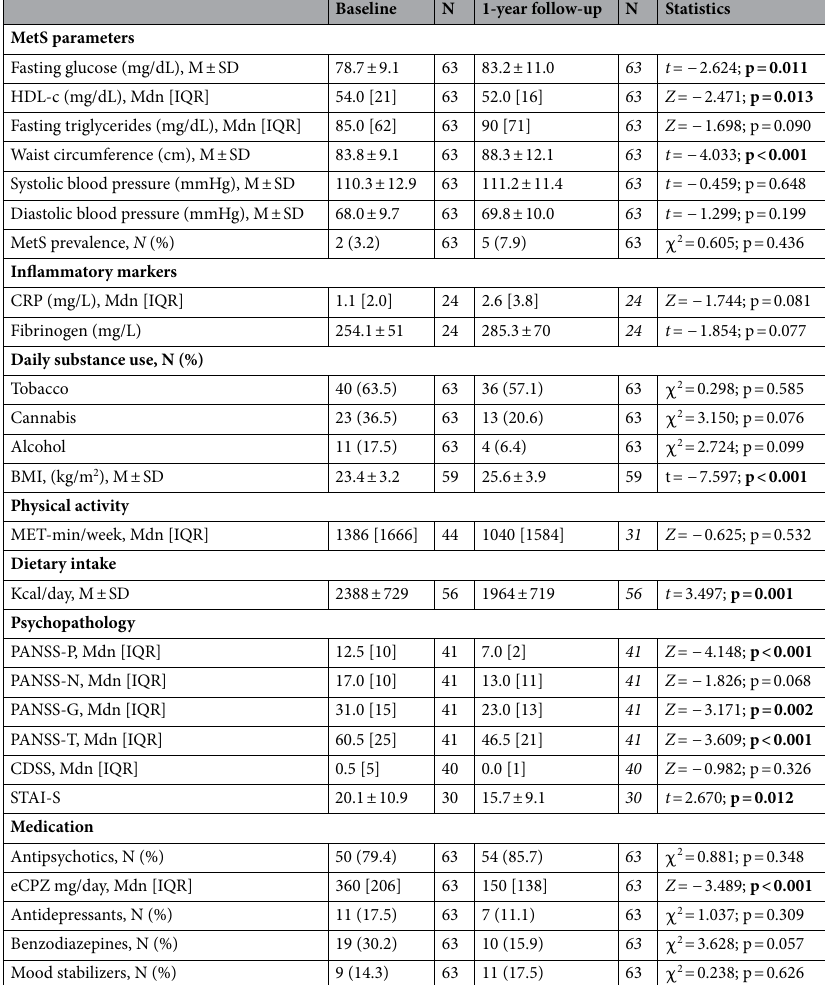
Table 2. Comparison of metabolic, lifestyle and clinical characteristics in patients with recent-onset psychosis (ROP) between baseline and the 1-year follow-up. M mean, SD standard deviation, Mdn median, IQR interquartile range, N number of cases, MetS metabolic syndrome, HDL-c high-density lipoprotein cholesterol, CRP C-reactive protein, BMI body mass index, MET metabolic equivalent task, PANNS-P Positive and Negative Syndrome Scale, positive subscale, PANSS-N PANSS, negative subscale, PANSS-G PANSS, general subscale, PANSS-T PANSS total score, CDSS Calgary depression scale for schizophrenia, STAI-S state-trait anxiety inventory-state subscale, eCPZ equivalents of chlorpromazine doses. Significant differences are indicated in